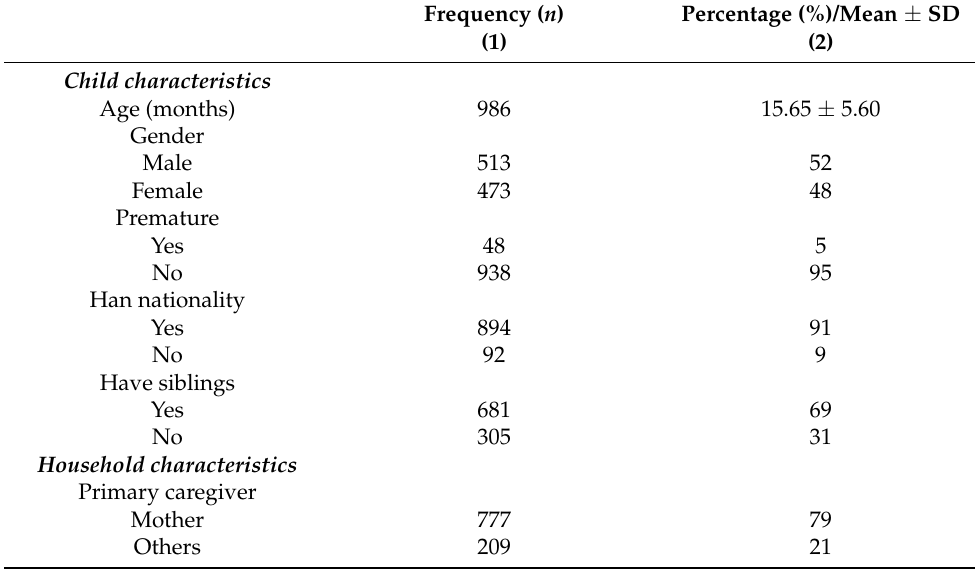
Table 1. Summary statistics, n =